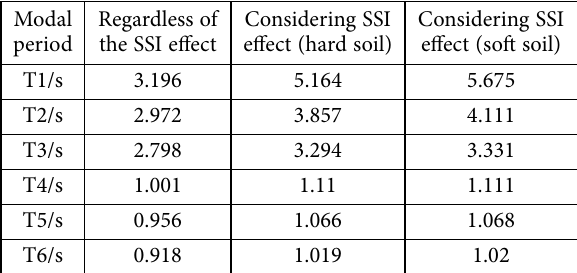
Table 6. Modal periods of new staggered story isolated